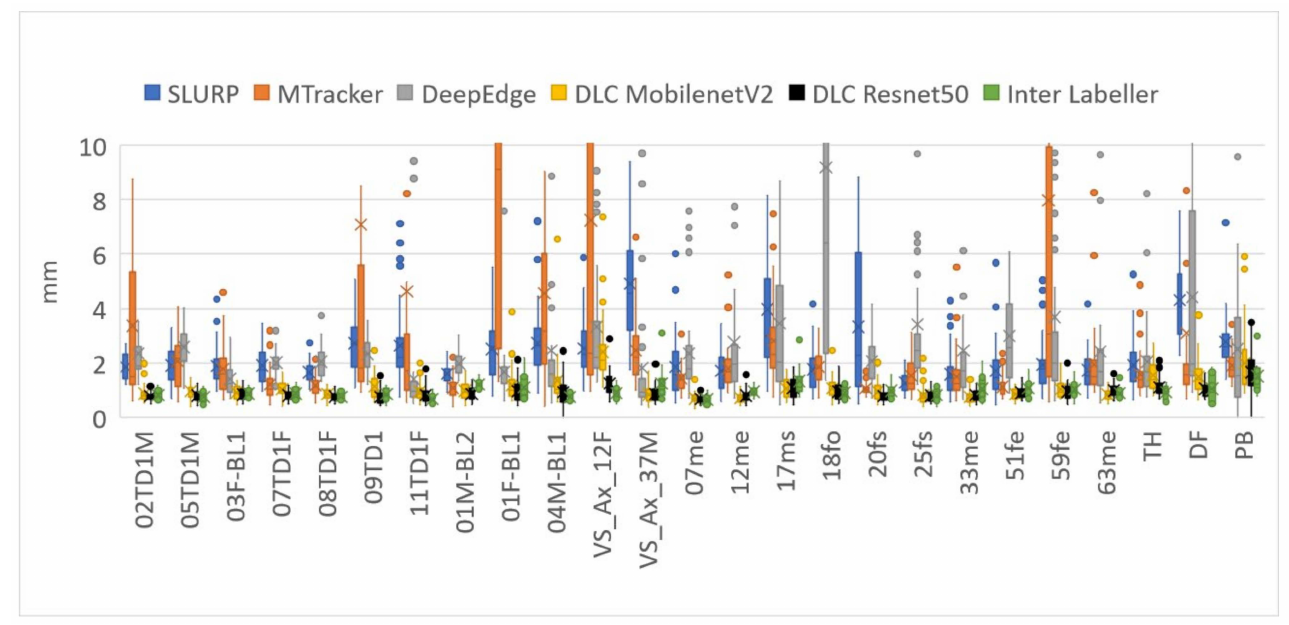
Figure 7. Mean sum of distances (MSDs) between hand-labelled randomly selected frames (40 frames for each speaker) and each of the assessed methods (DLC using MobileNetV2_1.0 encoder).